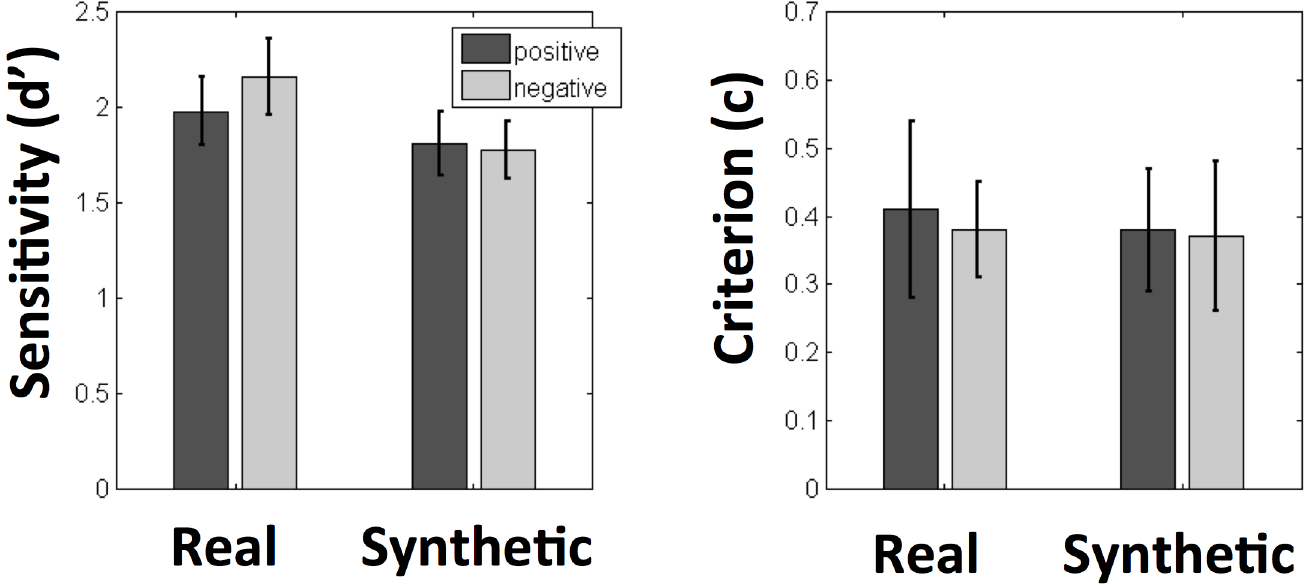
Fig 3. Average values for d ’ and c across participants for all conditions in our experiment.